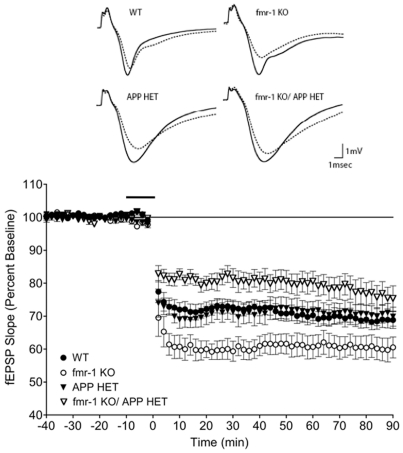
Rescue of mGluR-dependent synaptic depression in the CA1 in Fmr1KO/AppHET mice.(Top) Representative fEPSP taken before the addition of DHPG (solid lines) and at the end of the recordings (dotted lines). (Bottom) Time course of CA1 fEPSP slope after incubation with DHPG (50 µM, 10 min) in hippocampal slices from WT (black circles) (n = 20), Fmr1KO (white circles) (n = 13), AppHET (black triangles) (n = 15) and Fmr1KO/AppHET (white triangles) (n = 10) male mice (3 months old). WT, AppHET and Fmr1KO/AppHET were all statistically different from Fmr1KO by two-way ANOVA/Bonferroni multiple comparison tests. WT versus AppHET, p = 0.92; WT versus Fmr1KO, p<0.006; WT versus Fmr1KO/AppHET, p<0.02; AppHET versus Fmr1KO/AppHET, p<0.04; AppHET versus Fmr1KO, p = 0.02; Fmr1KO versus Fmr1KO/AppHET, p<0.0002. Error bars indicate SEM.